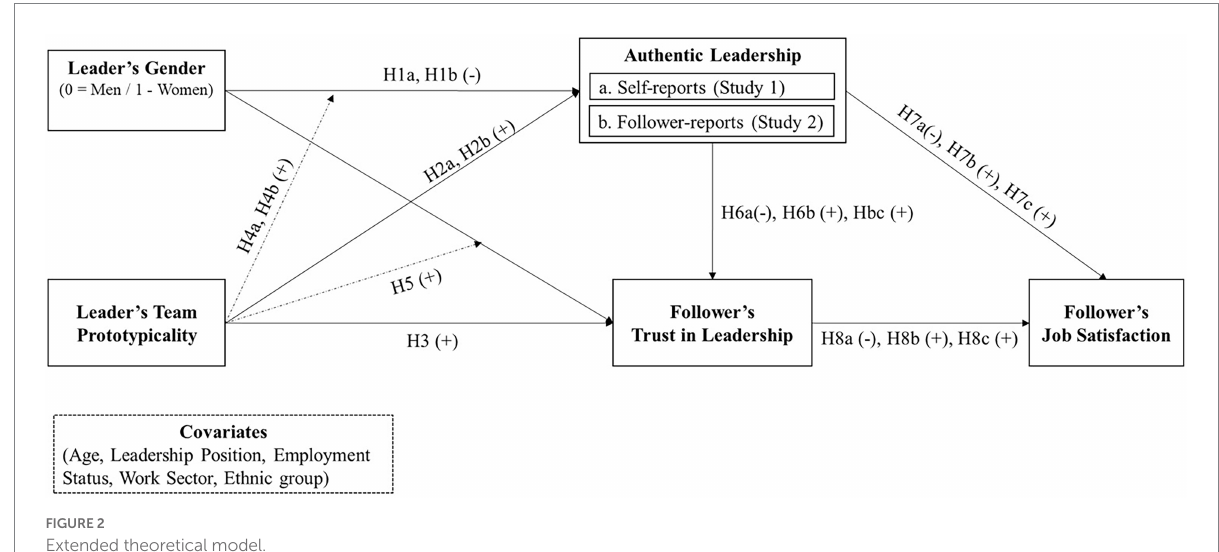
FIGURE 2 Extended theoretical